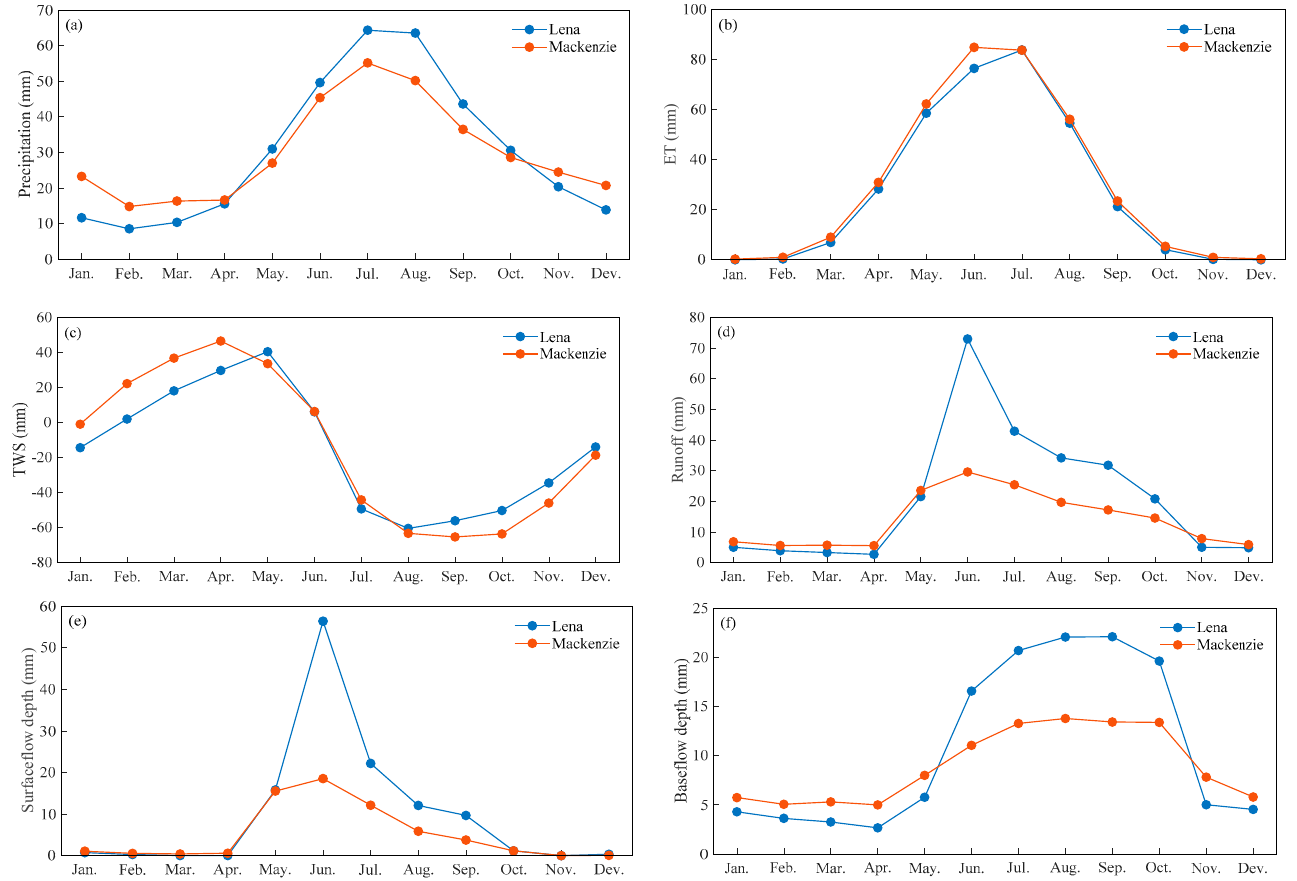
Figure 8. Mean annual cycles of precipitation ( a ), ET ( b ), TWS ( c ), runoff depth ( d ), surface flow ( e ) and base flow ( f ) in the LRB and MRB during 2003–2016.